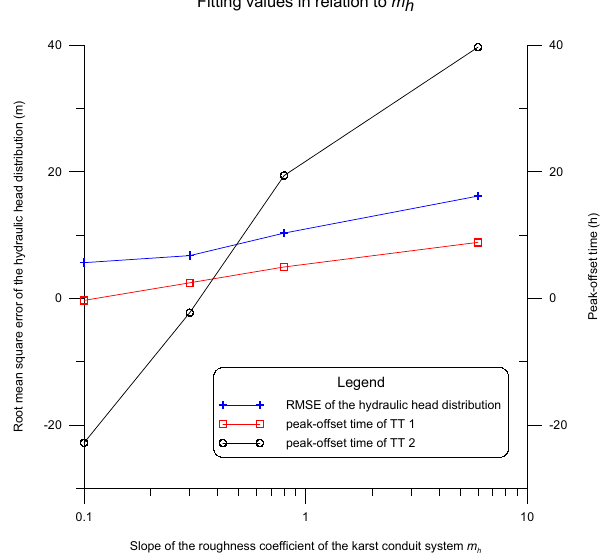
Figure 6. Hydraulic head errors and differences between peak con- centration times for both tracer tests for scenario 1. The example is shown for a conduit geometry with a starting value b = 0.01m and a radius increase of m = 2 × 10 − 4 . Each m h (m − 2 / 3 s − 1 ) value corresponds to a respective value of the highest conduit roughness b h (m 1 / 3 s − 1 ) and each combination results in the same spring dis-